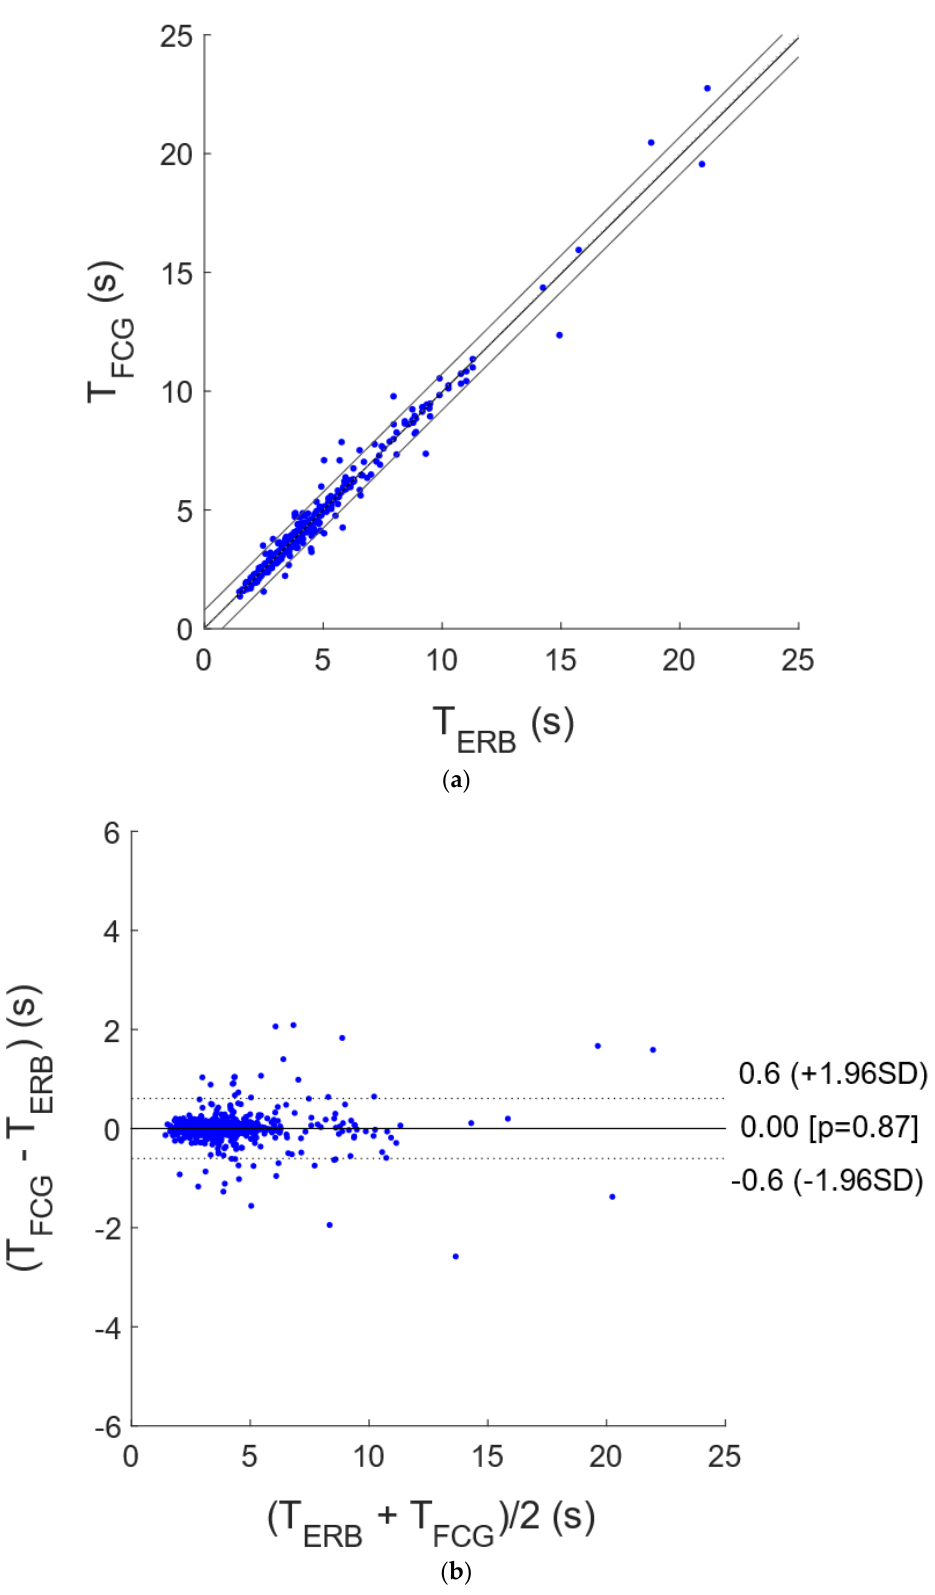
Figure 7. Statistical analyses on inter-respiration intervals estimated from FCG and ERB: ( a ) results of correlation analysis; ( b ) results of Bland–Altman analysis.